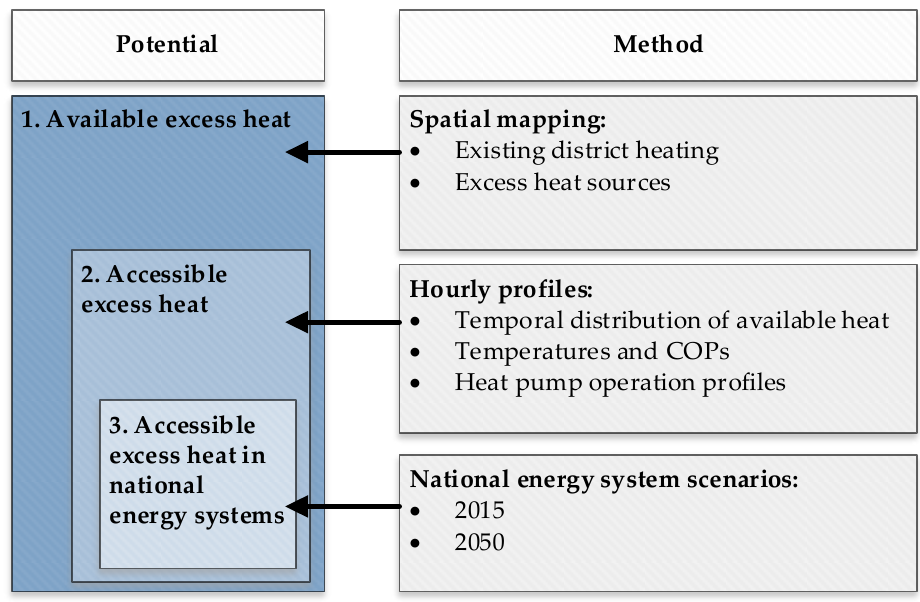
Figure 2. Analytical approach to estimating the excess heat potentials.